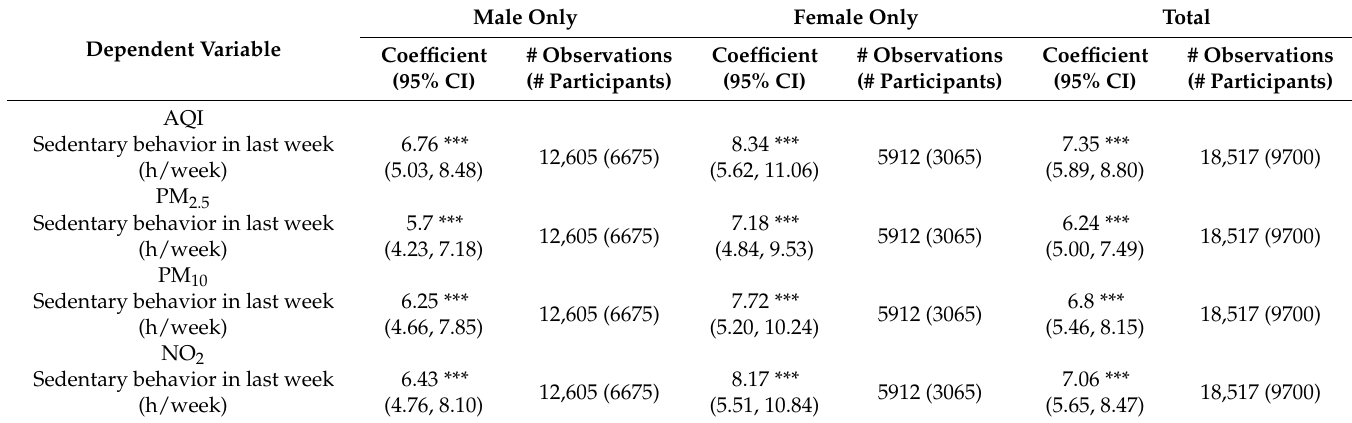
Table 3. Estimated effects of air pollution on individual-level sedentary behavior outcomes by